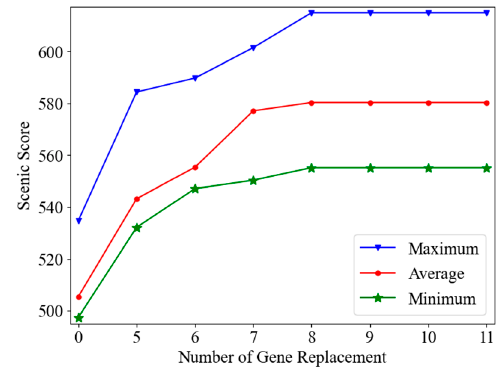
Figure 6. Number of gene replacements.